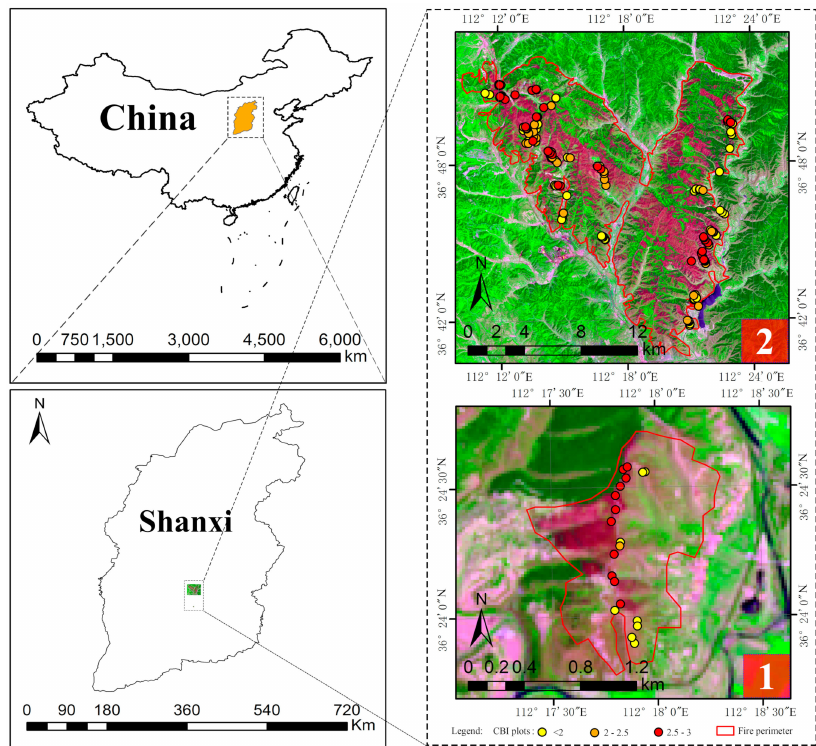
Figure 1. Location of the study area and surveyed field plots (dots in the figure) for fire 1 (bottom right panel) ignited on the 14 March (20 Composite Burn Indexes (CBIs)) and 2 (top right panel) ignited on the 29 March (143 CBIs). The background images used in the right two maps are the false-color composites (short wave infrared 2 (SWIR2), near-infrared (NIR), and red bands) of post-fire Sentinel-2A Multi-Spectral Instrument (MSI) data for the 30th June 2019. The fire perimeters are drawn manually based on di ff erenced Normalized Burn Ratio (dNBR) data of the two